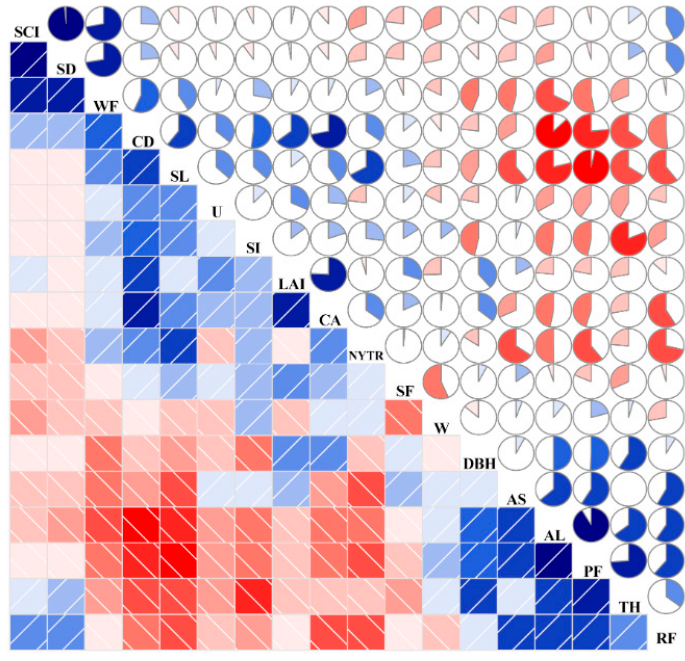
Figure 2. The correlation between the SSTFs and EFFIs. The bar and circle symbols use the same colors to indicate correlations with shading and saturation. The blue color with a diagonal line from the bottom left to the top right indicates two positively correlated variables, and the red color with a diagonal line from the top left to the bottom right indicates two negatively correlated variables. The darker the color, the greater the correlation between the variables. The blue pie chart filled clockwise from 12 o’clock indicates that the two variables are positively correlated, and the red pie chart filled counterclockwise indicates that the two variables are negatively correlated. Abbreviations: SSTFs, stand structure and topographical factors; EFFIs, functional indices of ecological function; WF, water-holding function; SF, soil improvement function; RF, function of reducing runoff and sediment yield on the slope; PF, diversity function of the understory plants; SL, slope; AS, aspect; AL, altitude; SD, stand density; CD, canopy density; NYTR, number of young trees renewed; DBH, diameter at breast height; TH, tree height; CA, crown area; LAI, leaf area index; W, uniform angle index; U, neighborhood comparison; SCI, stand competition index; and SI, stand layer